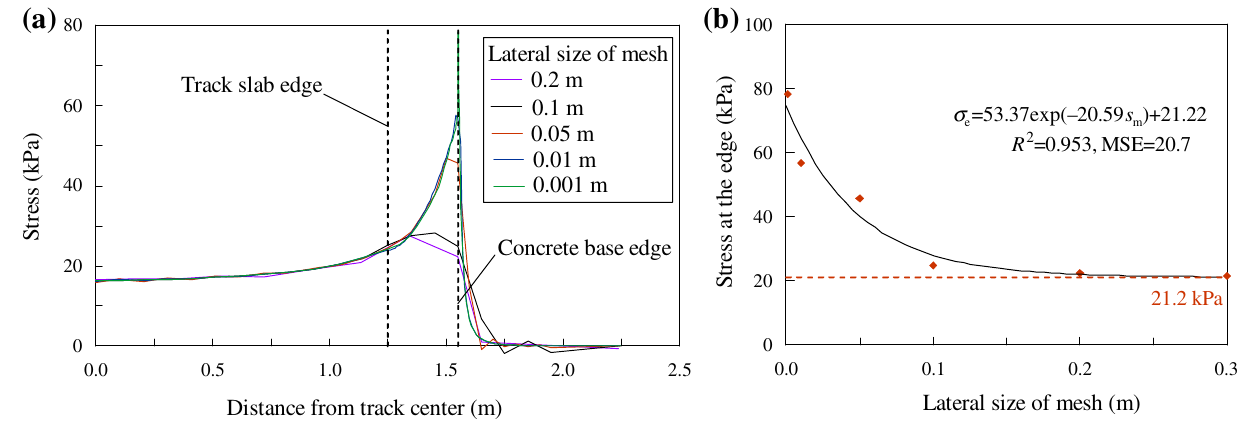
Fig. 8 Calculation of stress concentration at edge of concrete base: a effect of lateral mesh size; b fitting function: 𝜎 e is the stress at the edge, and s m is the mesh size